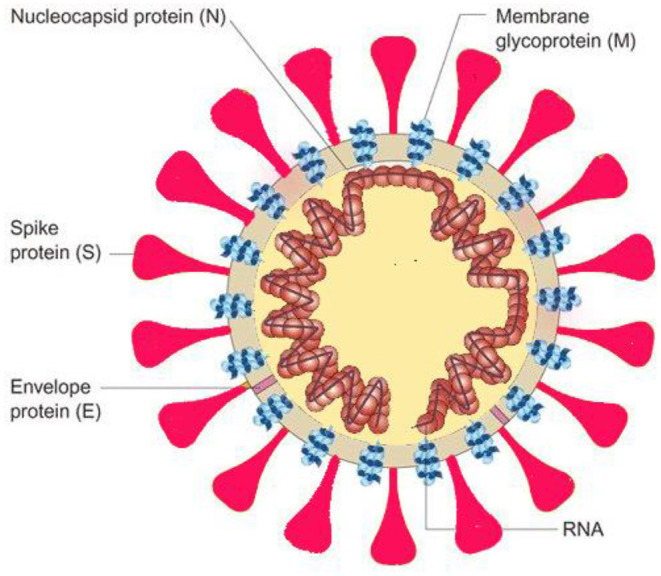
Illustration of viral structure with its structural viral proteins (4).